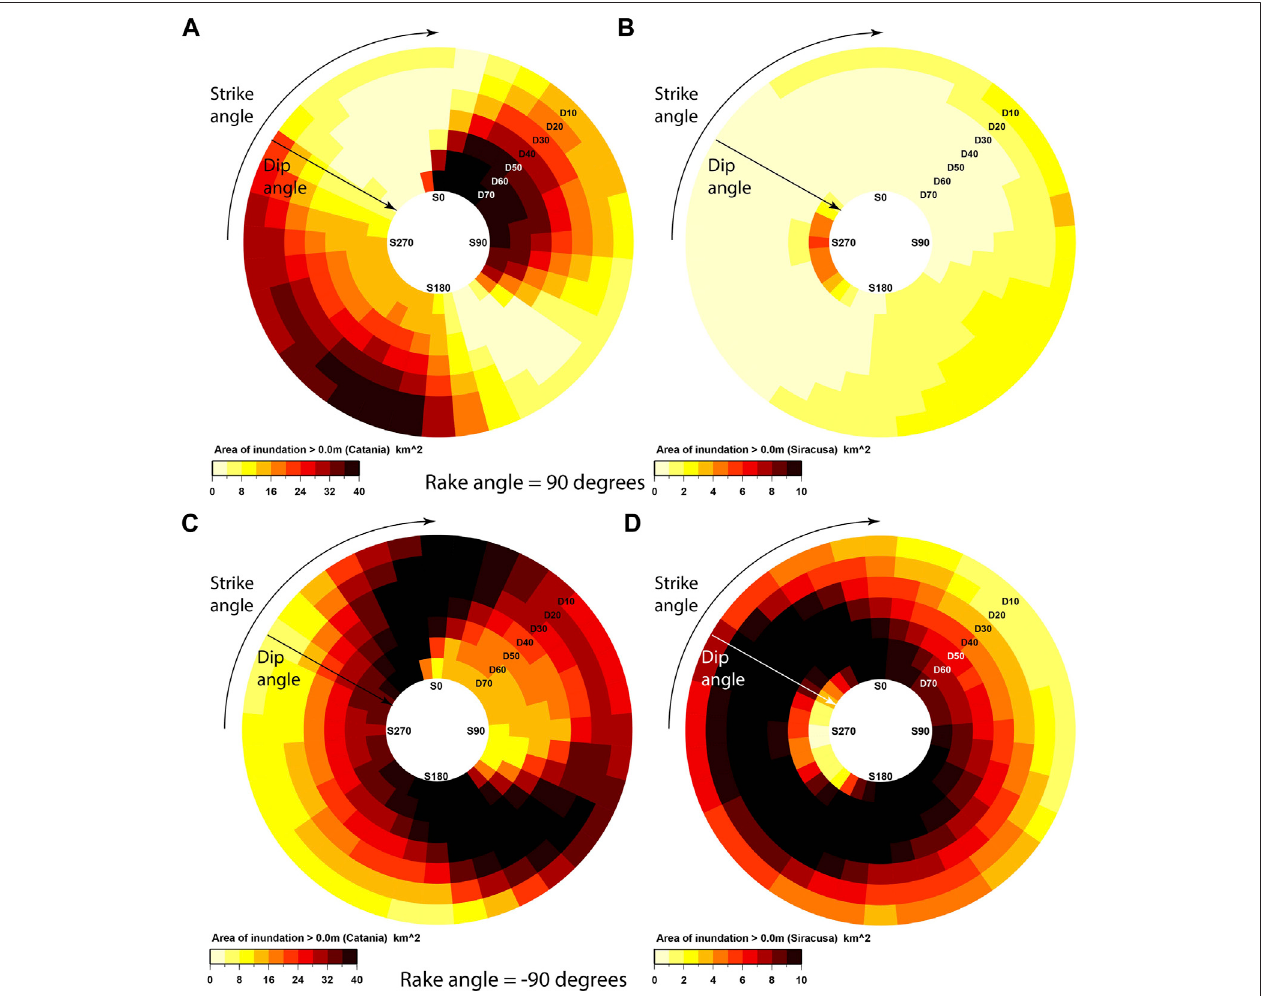
FIGURE10| Areaoftsunamiinundationinkm 2 forCataniaandSiracusafortheearthquakescenarioswithfaultcentersatpointB(near-shore).Panels (A,B) display inundation for rake (cid:1) 90 o , panels (C,D) for rake (cid:1) − 90 o . The colour scales differ for the two locations, re fl ecting the areas subject to inundation, but are identical for the normal and reverse sources at both